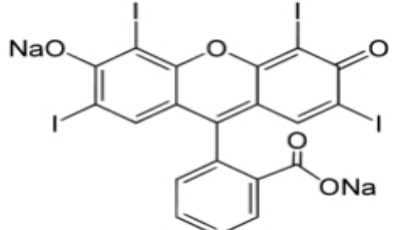
Fig. 2. Chemical structure of erythrosine